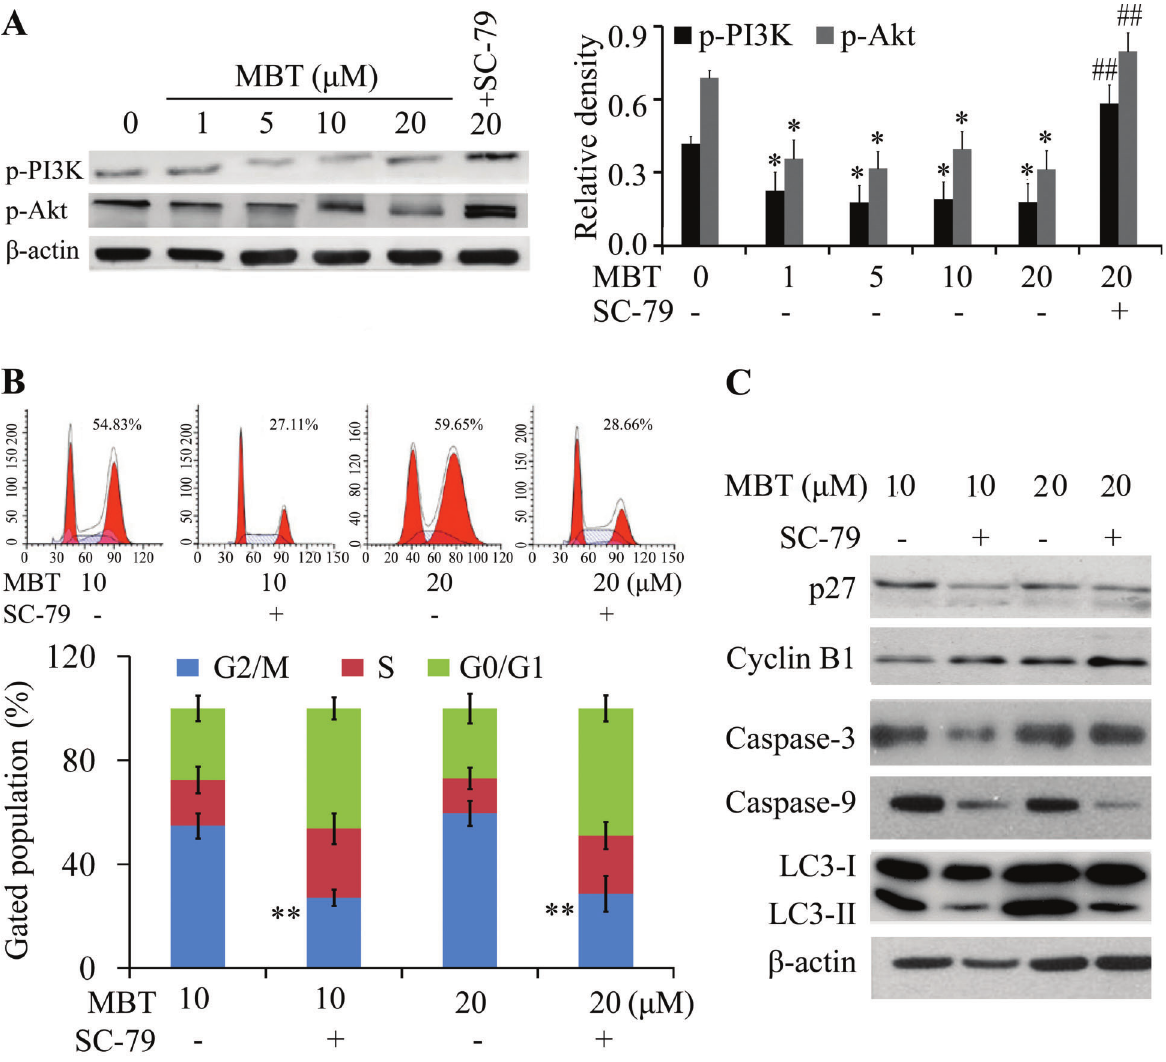
Figure 4. Role of PI3K/Akt in 2-methyl-2-butanol (MBT)-induced cell cycle arrest and autophagy in HXO-RB44 cells. A , Inhibition of p-PI3K and p-Akt in MBT-treated cells. *P o 0.05 vs 0; ## P o 0.01 vs MTB 20 (ANOVA and t -test). B , Effects of SC-79 on cell cycle arrest. **P o 0.01 vs MTB 10 or MTB 20 ( t -test). C , Effects of SC-79 on apoptosis and autophagy. Data are reported as means ±